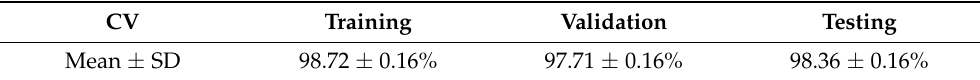
Table 10. Evaluation of the accuracy through training, validation, and testing with cross-validation (5-fold) in the second stage. CV